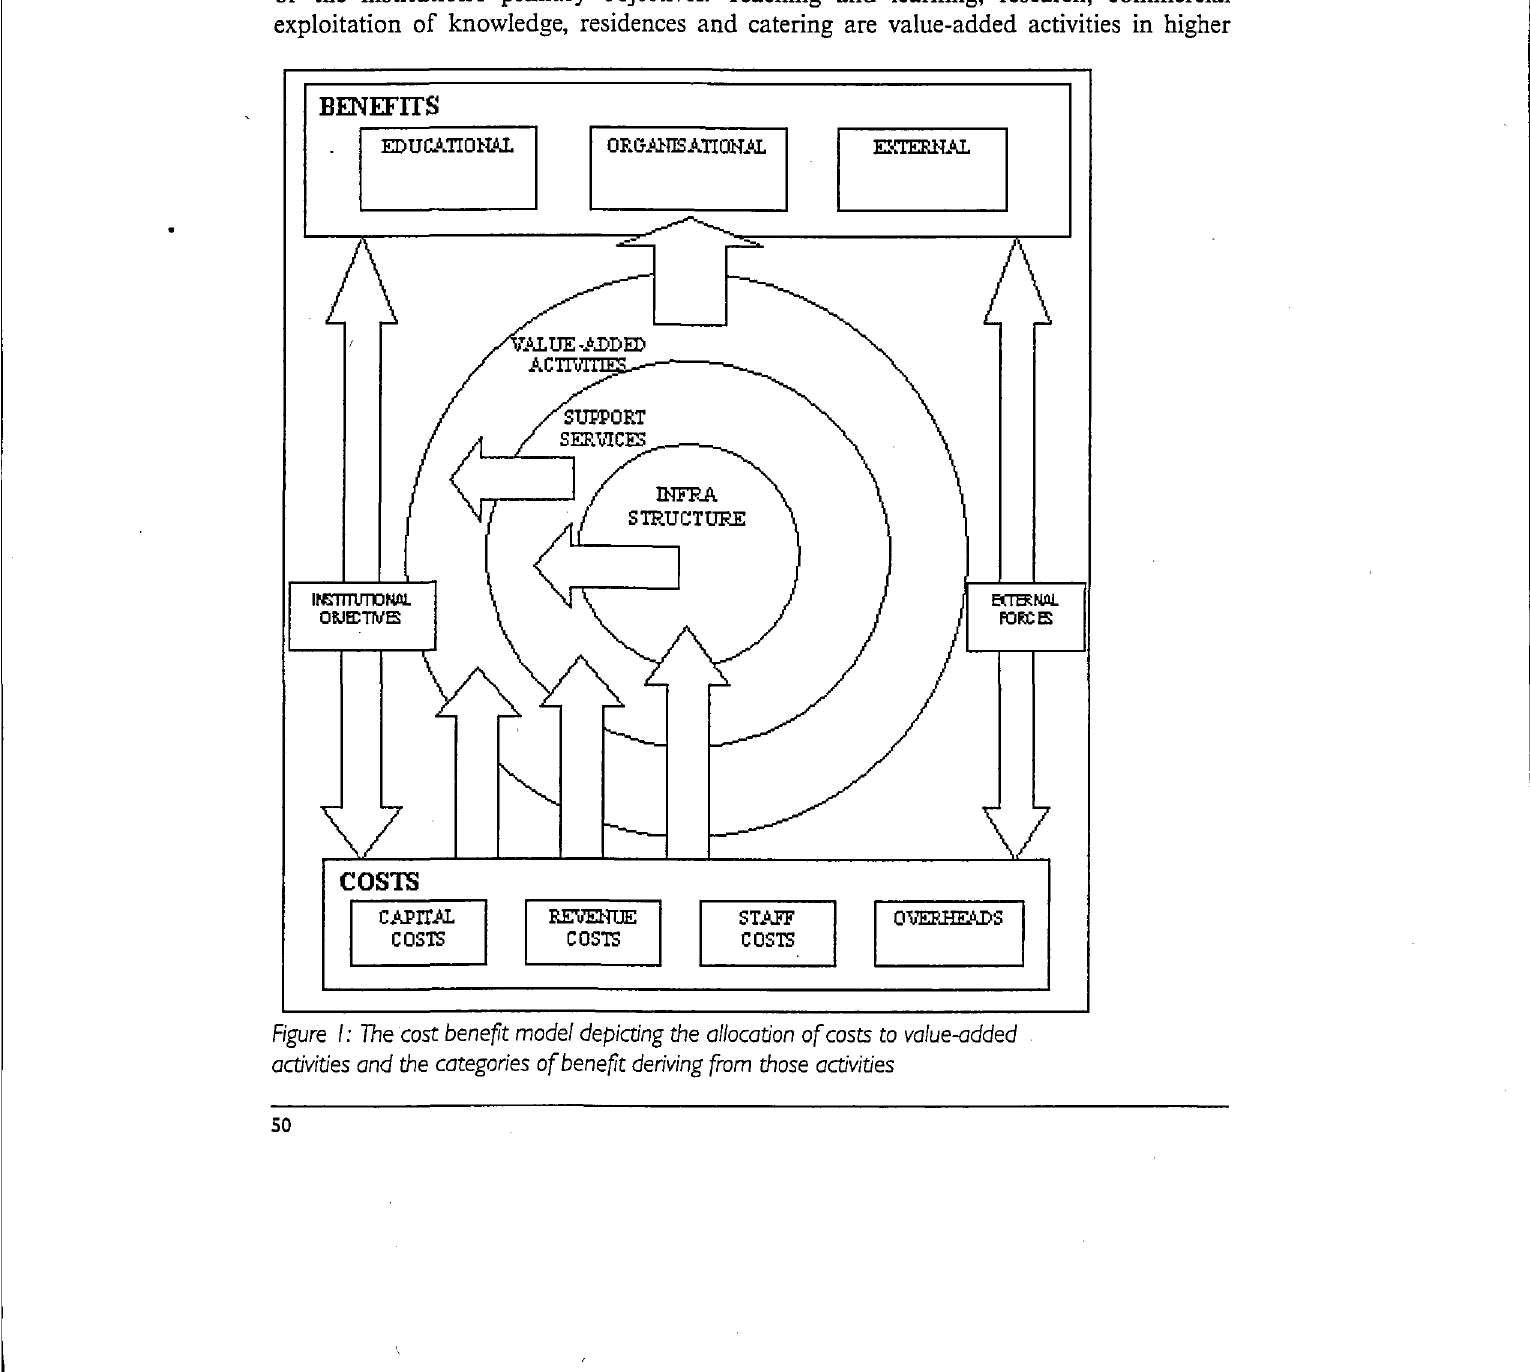
Figure I: The cost benefit model depicting the allocation of costs to value-added activities and the categories of benefit deriving from those activities